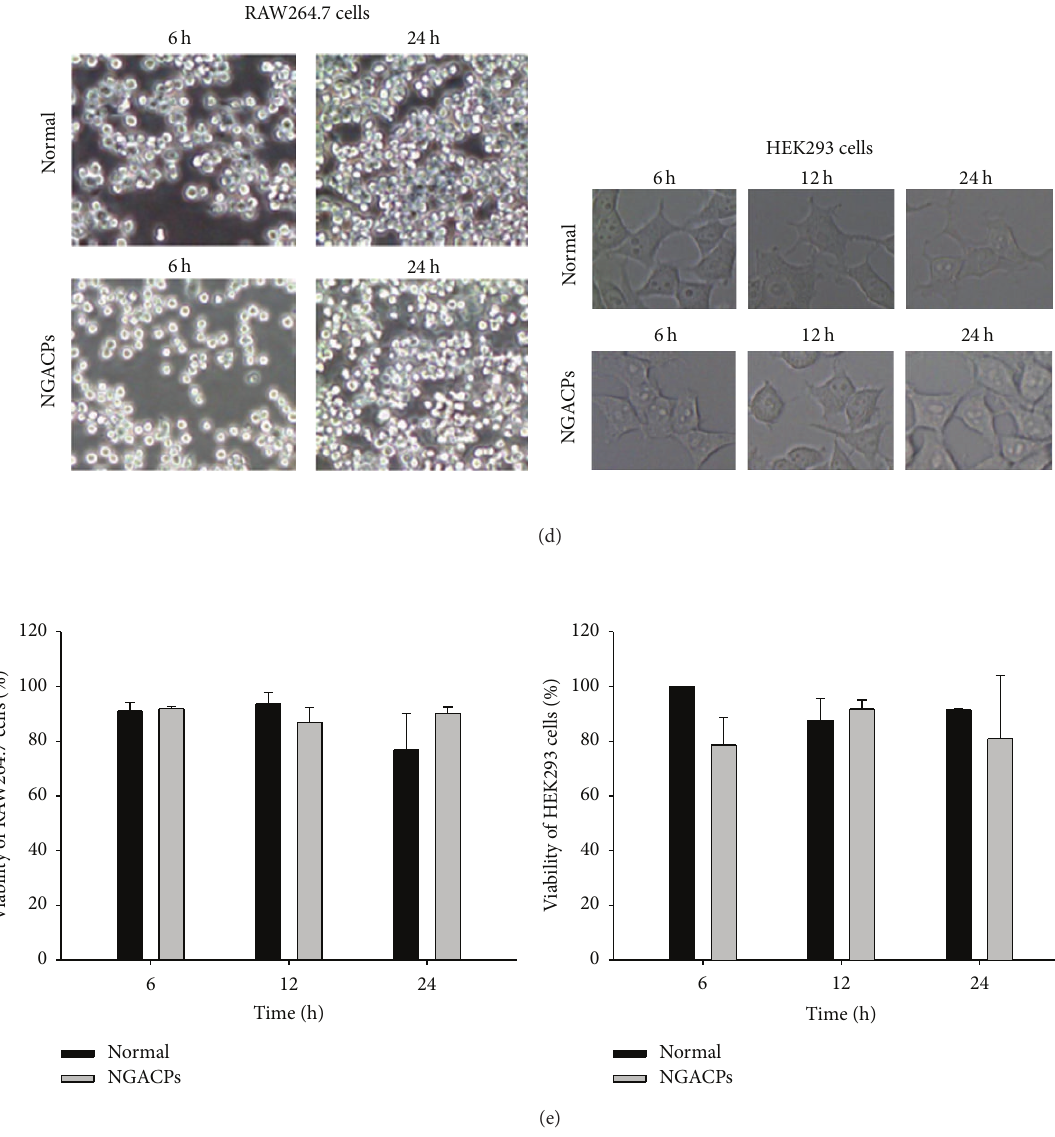
Figure 2: Effect of nanocurrent-generating ACPs (NGACPs) treatment on the production of inflammatory mediators. ((a), (b), and (c)) The levels of NO and PGE 2 were determined using a Griess assay and EIA with culture supernatants from RAW264.7 cells or peritoneal macrophages that had been treated with NGACP and LPS (1 𝜇 g/mL) or pam3CSK (10 𝜇 g/mL) for 6 or 24 h (NO and PGE 2 , resp.). (d) Morphological alterations in RAW264.7 cells and HEK293 cells were photographed using a digital camera. (e) The viability of RAW264.7 and HEK293 cells was determined using an MTT assay. ∗ P < 0.05 and ∗∗ P < 0.01 compared to control.